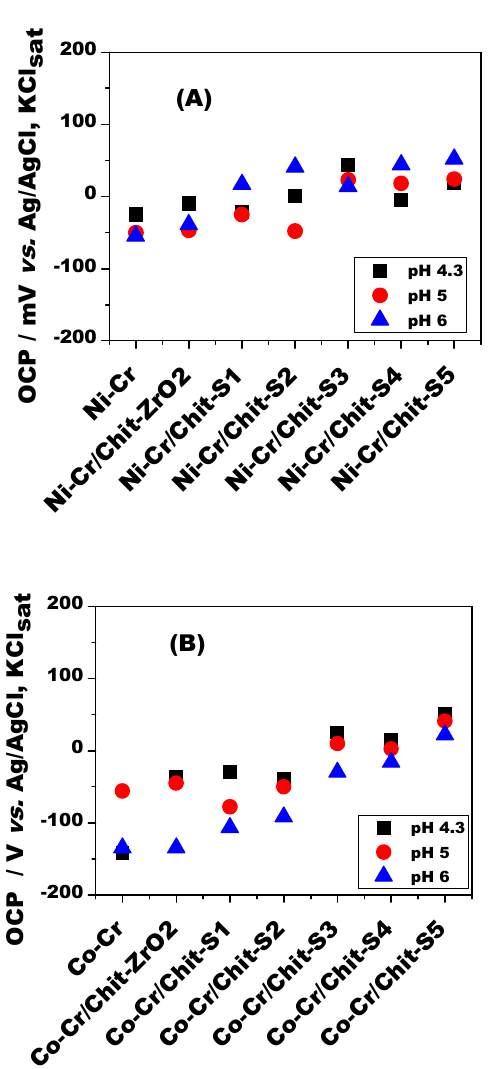
Figure 3. Variation of open circuit potential at Ni-Cr ( A ) and Co-Cr ( B ) based modified electrodes at different pH values and at different electrode interfaces.